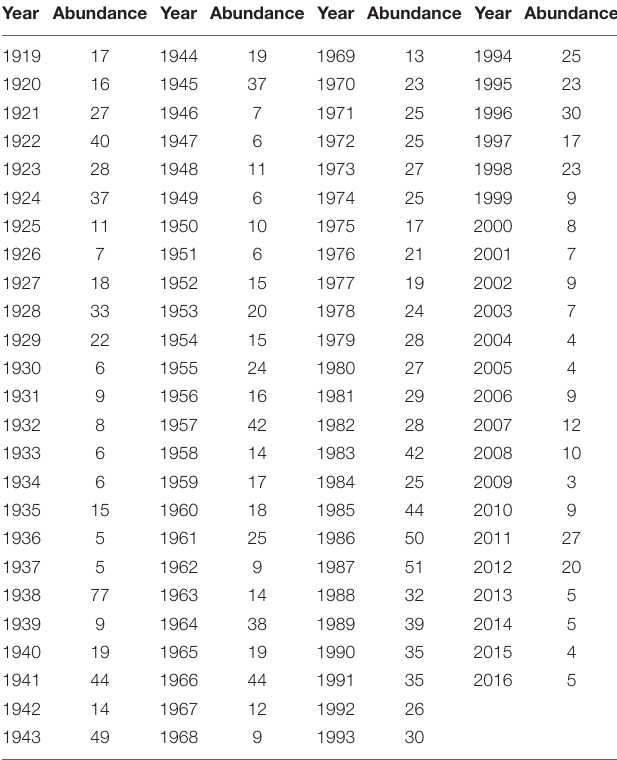
TABLE 1 | Annual average global abundance of Atlantic